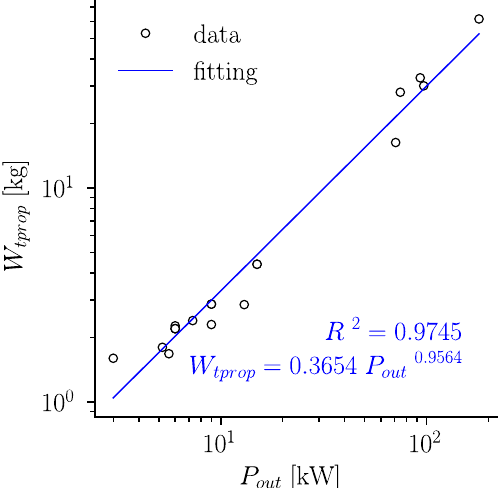
Figure 8. Weight of turboprop engines ( W tprop ) as function of the cruise power output ( P out ) from 2 to 200 [kW]. n = 20.